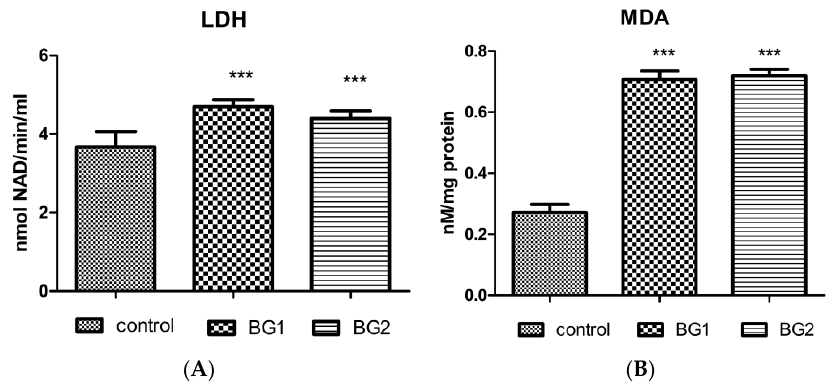
Figure 8. LDH activity and MDA levels in the supernatant of DOK cells exposed to the two BGs compared with untreated control cells: ( A ) LDH activity was significantly increased in the supernatant of DOK after BG exposure, compared with the control ( p < 0.001); and ( B ) MDA levels after 24 h of exposure to 2 µg/mL BG1 and BG2 were enhanced, compared with control cells ( p < 0.001). The statistical significance of the difference between exposed and control groups was evaluated by two- way ANOVA and paired Student’s t -test followed by the Bonferroni post-hoc test. Data are expressed as the mean of triplicate measurements ± SD. *** p < 0.001 vs. control.